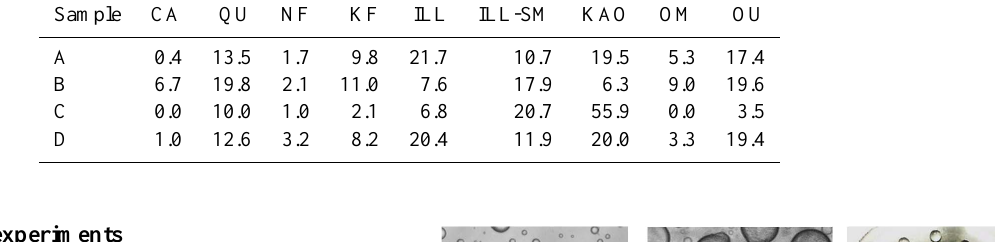
Table 2. Mineralogies of the soil dusts (<11µm) determined by X-ray diffraction (XRD). Listed in weight percent are: CA – calcite, QU – quartz, NF – Na-feldspar, KF – K-feldspar, ILL – illite, ILL-SM – illite-smectite, KAO – kaolinite, OM – other minerals: the sum of the rarer minerals in the samples, and OU – others unidentified: material which was not resolved using XRD. Sample CA QU NF KF ILL ILL-SM KAO